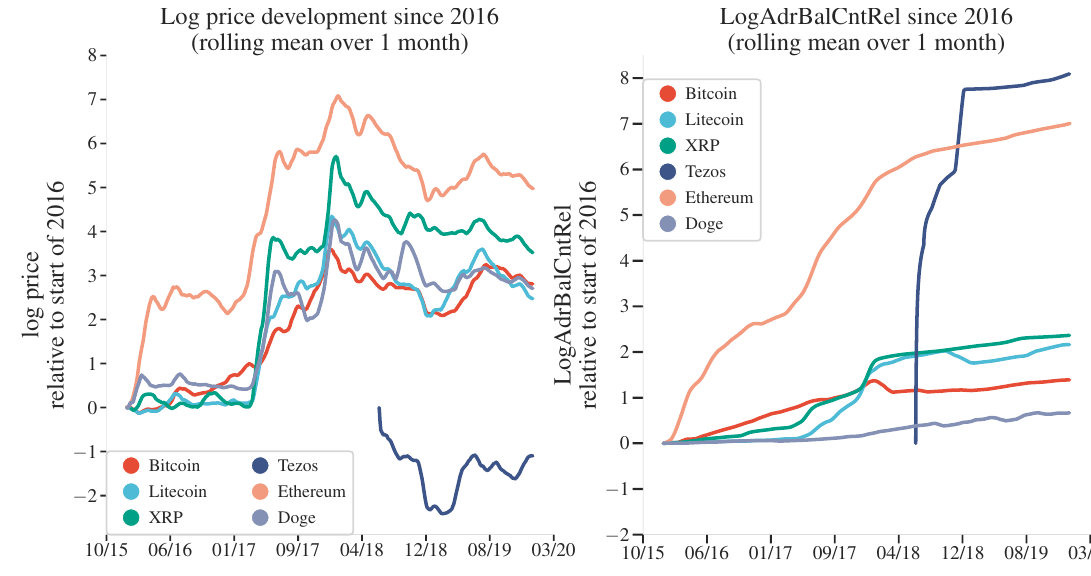
Fig. 1. Price and userbase development since